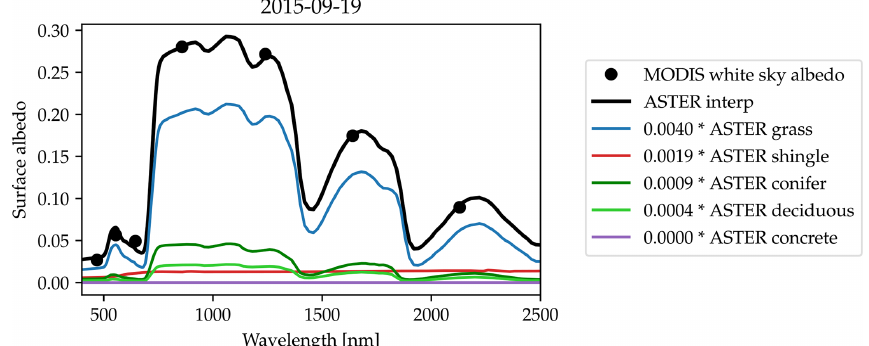
Figure B6. Spectral albedo data from the ASTER library provided with a resolution of 2nm for grass (blue), shingle (red), conifer (dark green), and deciduous trees (green) as well as concrete (purple). A linear combination for the different ASTER albedo types is determined which represents best the averaged MODIS data from Fig. B5 by applying the least-squares method. The weighting factors for 19 September 2015 are provided in the legend of the figure. The resulting mixture of ASTER albedo data is then used to obtain an approximation of the MODIS albedo product for high spectral resolution, which is represented by the black solid